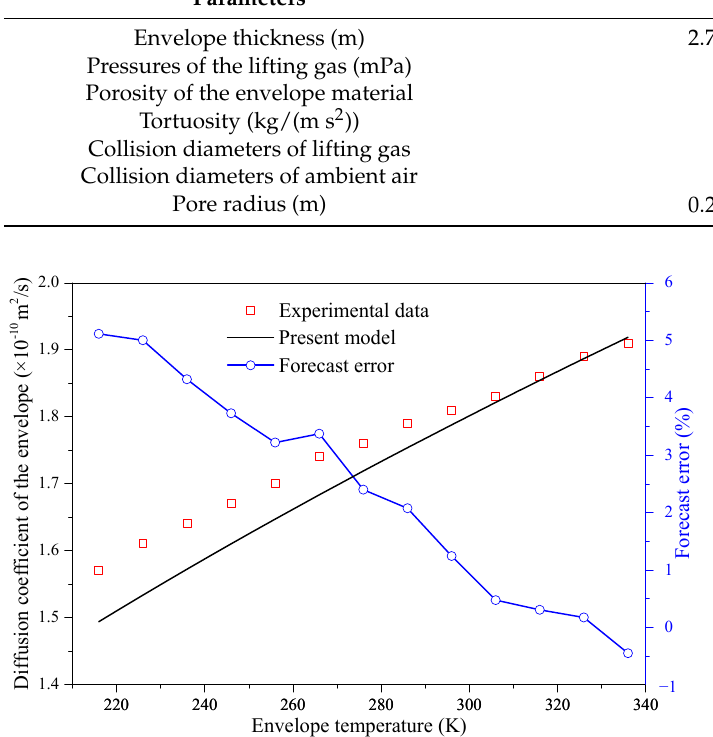
Figure 7. Comparisons of the diffusion coefficient of the envelope [43].